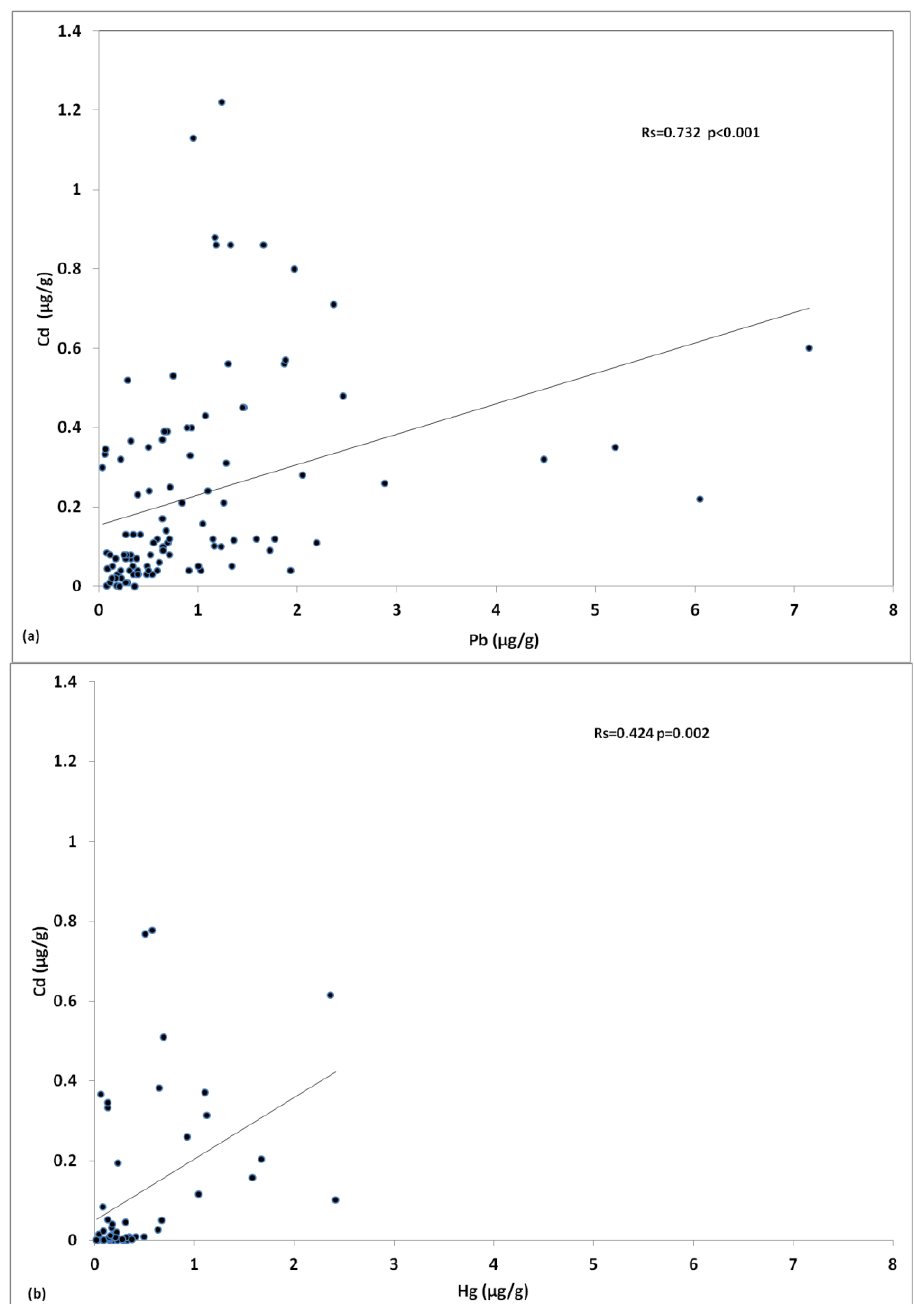
Figure 2. ( a ) Correlation of Cd levels with Pb levels in fish tissue presented in the reviewed literature; ( b ) Correlation of Cd levels with Hg levels in fish tissue presented in the reviewed literature; ( c ) Correlation of levels Hg with Pb levels in fish tissue presented in the reviewed